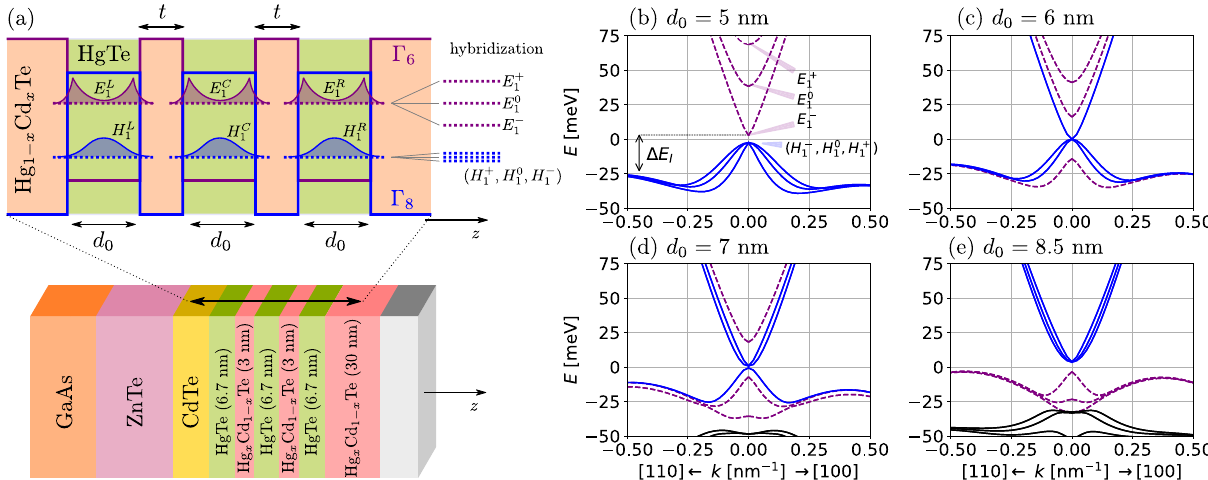
Figure 1. ( a ) Conduction and valence band edges of the triple quantum well schematically shown in the 0.3 ) are indicated. bottom. The widths d 0 of the HgTe wells and the thickness t of the Hg 1 x Cd x Te barriers ( x = − Single well states located on each of left (L), central (C) and right (R) wells are illustrated in purple (electron- like) and blue (hole-like). As t decreases their hybridization leads to a large energy splitting of the E-like states 0 , while the H-like remain nearly degenerate due to the larger effective mass. (b,c,d) Band structures for at k = 5 nm, in the trivial regime, all E subbands are above the H subbands. 3 nm and varying d 0 . ( b ) For d 0 t = = (cid:31) E I indicates the indirect band gap. Phase transitions occur as each E subband crosses the H subbands with 6 nm, ( d ) d 0 7 nm, and ( e ) d 0 8.5 nm. For large d 0 the indirect gap (cid:31) E increasing ( c ) d 0 I closes and = = = 8 Kane the system becomes semi-metallic (shown in the Supplementary information which contains the 8 × Hamiltonian 53–56 , the table of material parameters, the expressions for the matrix elements of the 2D model 42,43 , and extra figures complementing the ones in the main text). All of the plotted subbands above present degeneracy in